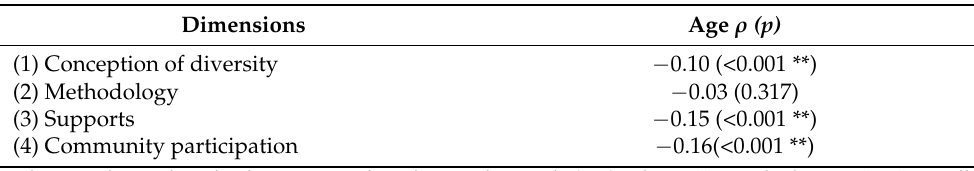
Table 4. Correlations between the dimensions and the age